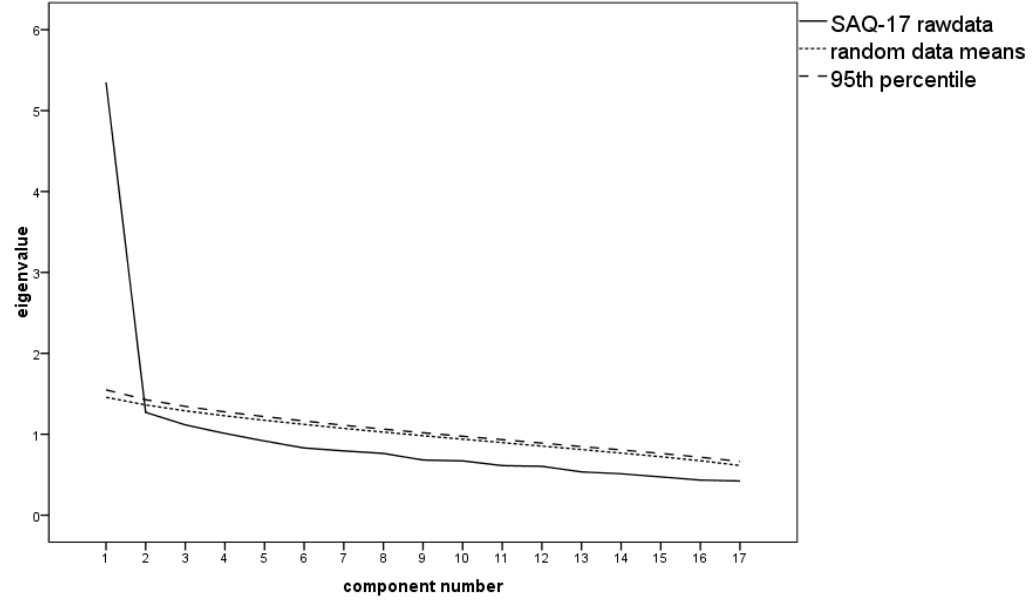
Figure 3. Scree plot with the parallel analysis of the Self-Awareness Questionnaire (SAQ-17) proposing extraction of one factor. Table 6. EFA communalities and factor loadings of the items in the SAQ-17 single-factor